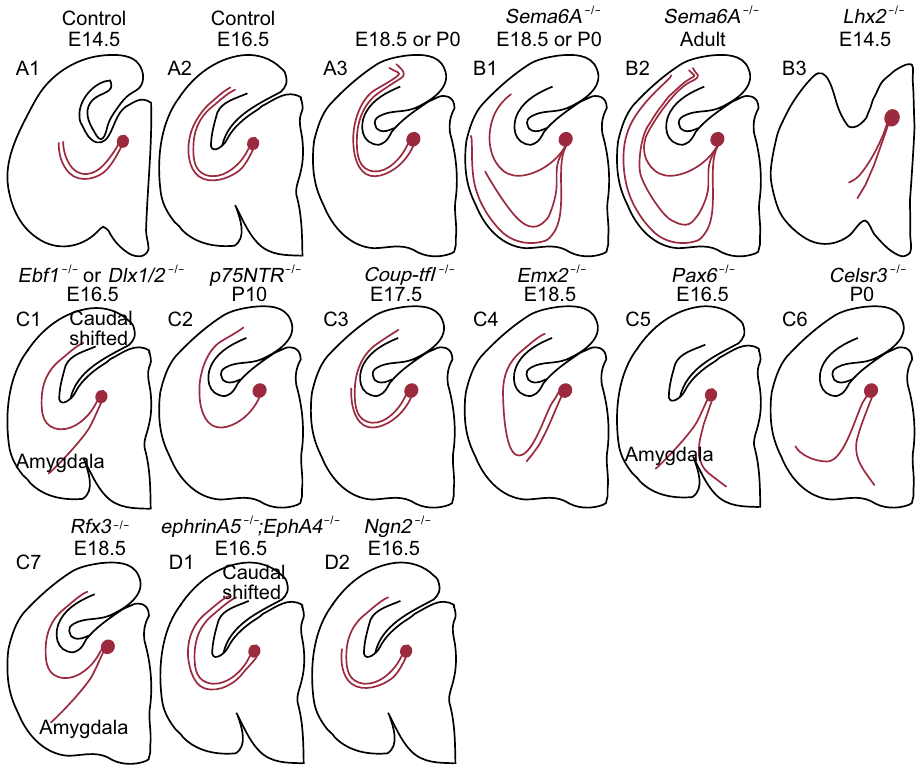
Figure 5. Schematics of the path fi nding of thalamocortical axons after knocking out genes related to guidance cues. (A) Normal development of thalamocortical axon path fi nding from E14.5 to P0. (B1 – 3) Phenotypes of thalamocortical axons after knocking out TC axon guidance cues including Semaphorin-6A and Lhx2 . (C1 – 7) Phenotypes of thalamocortical axons after knocking out TC pathway intrinsic cues including Ebf1 , Dlx1/2 , p75NTR , Coup-tfI , Emx2 , Pax6 , Celsr3 and Rfx3 . (D1 – 2) Phenotypes of thalamocortical axons after knockout of topographic mapping cues such as ephrin-A5 ; EphA4 and Ngn2 . Red dots represent dLGN projecting neurons. Red lines stand for TC